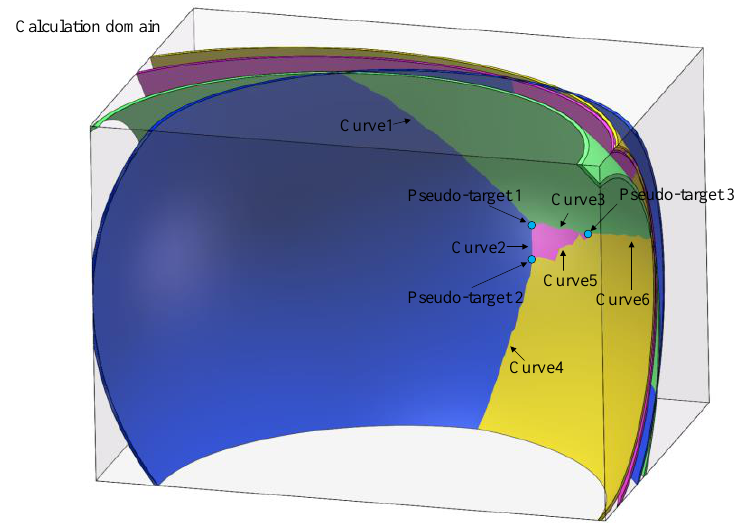
Figure 4. The four ellipsoids do not intersect at one point because of ToF measurement errors. T . For disjoint curves, as shown in Figure 5b, zooming j